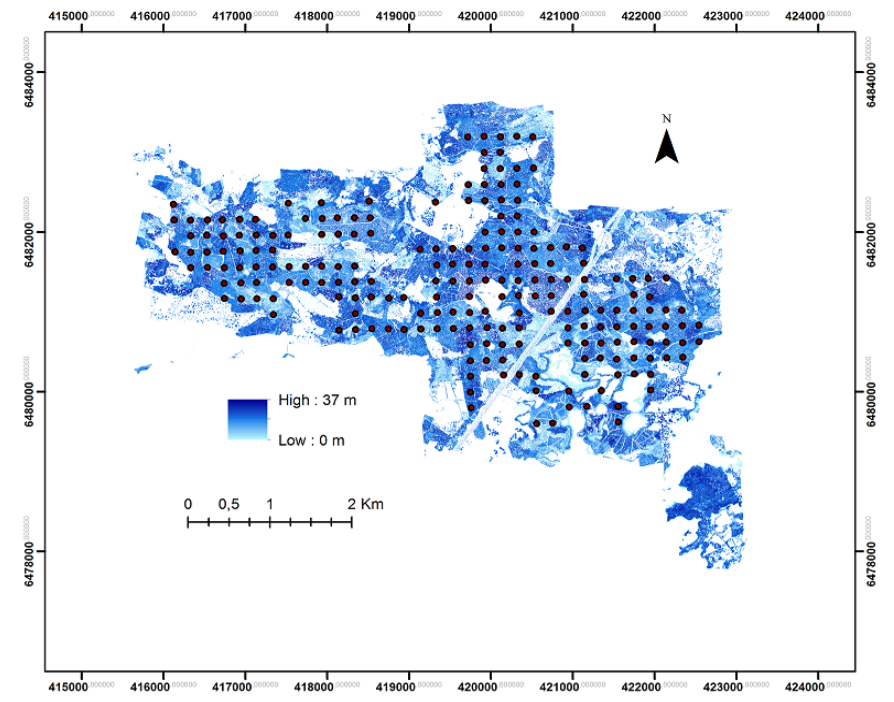
Figure 4. Available CHM from Lidar of the Remningstorp area. Dark circles show the location of field